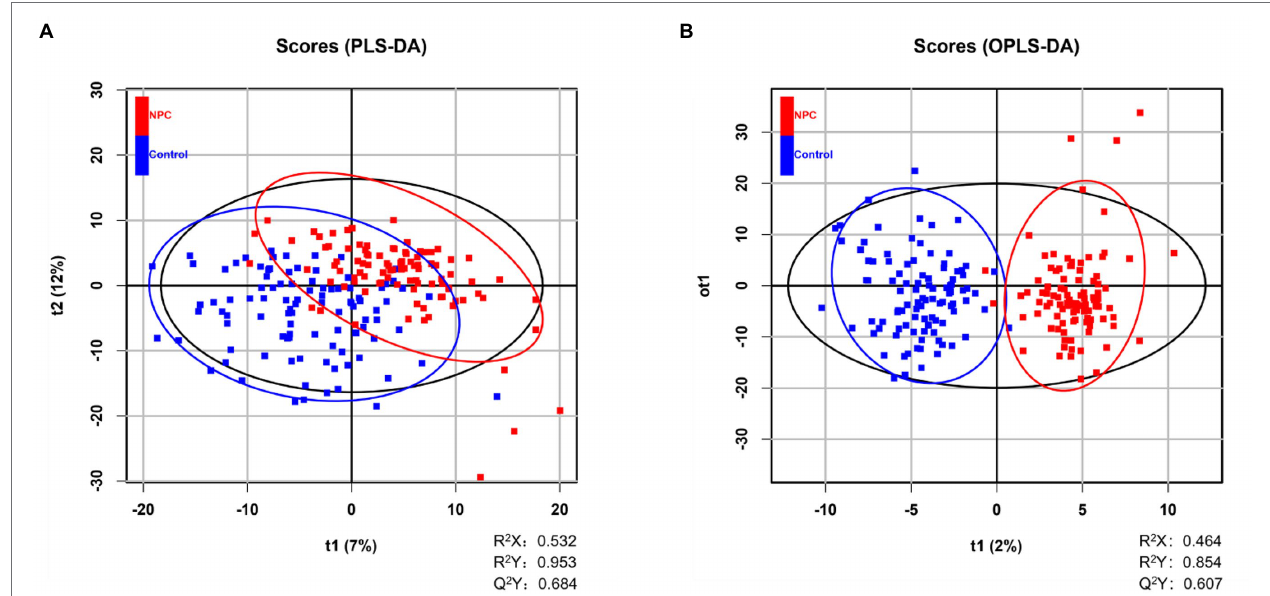
FIGURE 2 | Distinguishing NPC patients from controls using supervised statistical analyses. (A) NPC patients and controls are partially distinguished based on 2-dimensional scores made by PLS-DA, where Q 2 > 0.5 and R 2 > 0.5 indicate the predictive ability of the model. A blue square represents a healthy control whereas a red square represents an NPC patient. (B) Score plot of OPLS-DA showing the separation of NPC patients and controls, where Q 2 > 0.5 and R 2 > 0.5 indicate the predictive ability of the model. A blue square represents a healthy control whereas a red square represents an NPC patient.